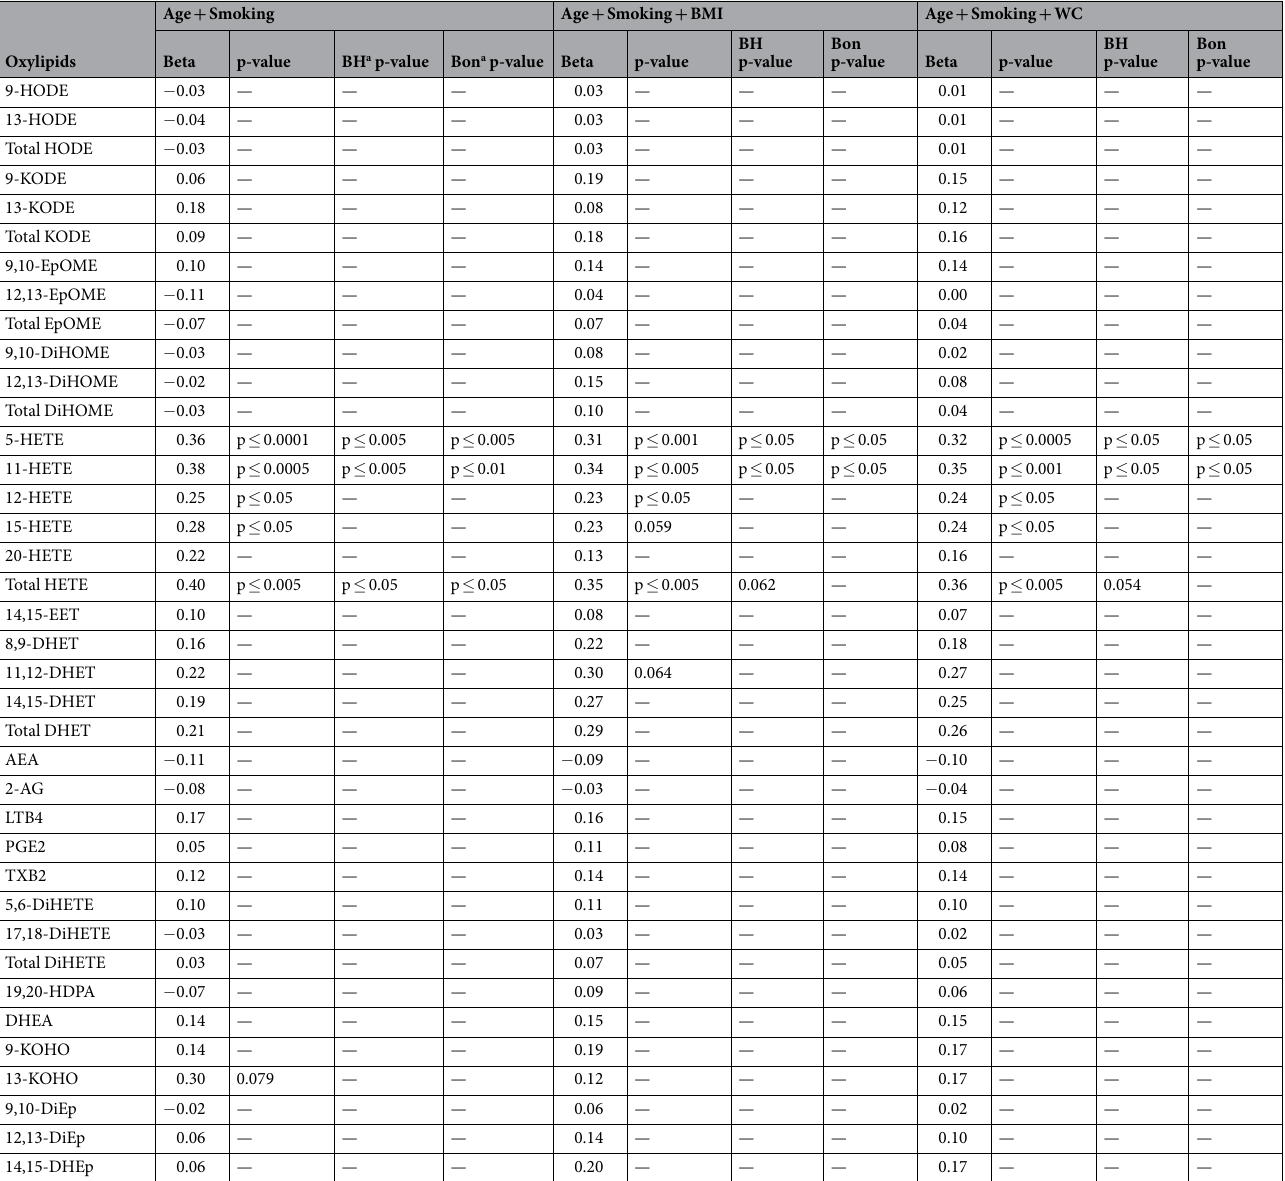
Table 3. After PUFA-normalization arachidonic acid-derived oxylipids remain significantly associated with polyp type. Beta coefficients and p-values were determined through general linear regression with Poisson distribution. Models were defined as Polyp type = Age + Smoking + log(oxylipid/PUFA), Polyp type = Age + Smoking + BMI + log(oxylipid/PUFA), and Polyp type = Age + Smoking + WC + log(oxylipid/ PUFA). P-values were adjusted for false discovery rate (FDR) according to Benjamini-Hochberg and Bonferroni. Only p-values < 0.1 are displayed. Oxylipids totals calculated as follows: Total HODE =